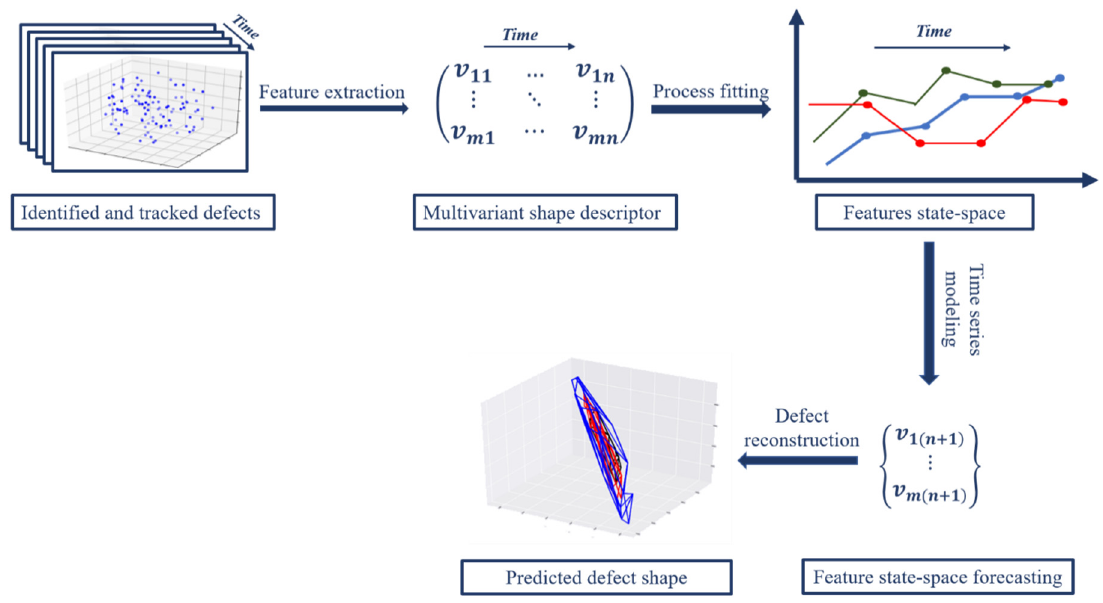
Figure 1. Schematic overview of the proposed methodology for life-cycle modeling of remotely sensed defects.